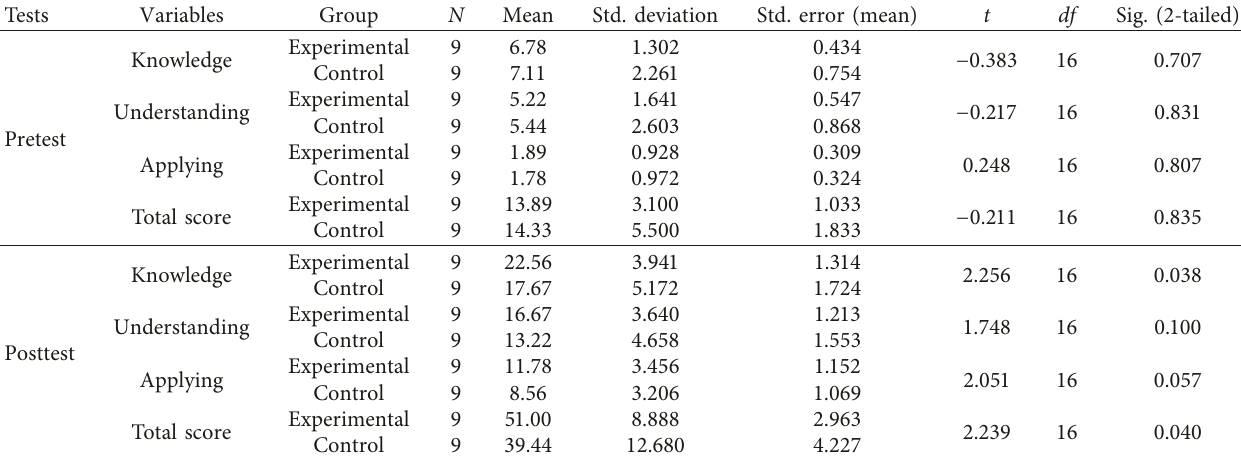
Table 2: Independent sample t -test for pre- and posttest of low-achiever